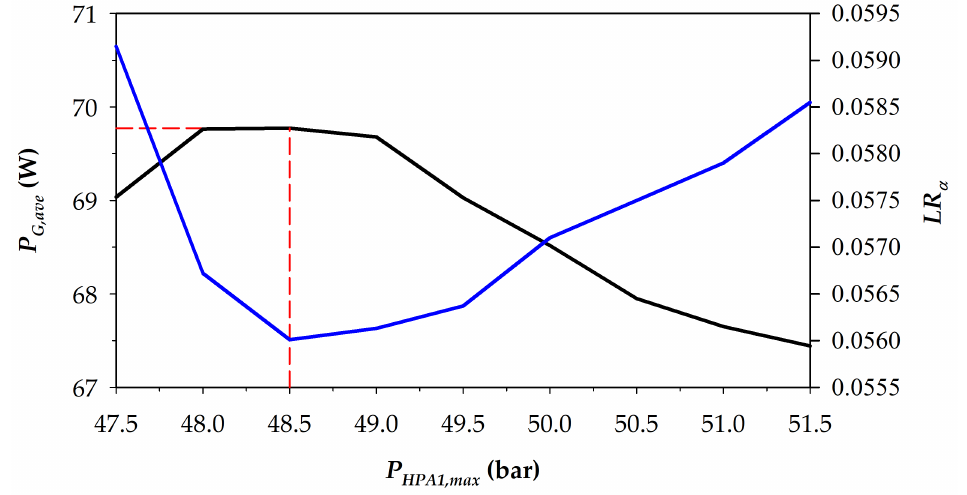
Figure 27. The average of P G , imp . and LR α corresponds to different P HPA 1, max